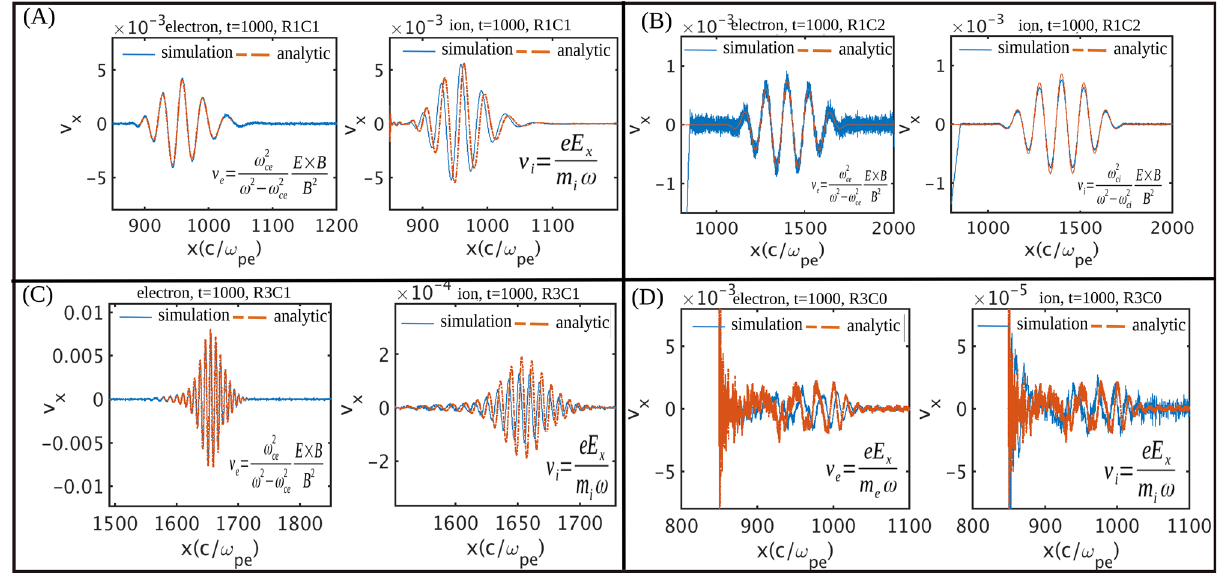
Figure 9. Comparison of electron and ion drift theoretically (Eq. 7) and simulation results. In criteria II both species are magnetized and their drift velocity in longitudinal direction is also same such that there’s no charge separation which can inhibit the propagation of EM wave ( B ). In the case when ω l > ω ce , there’s generation of subplot ( A ) and ( C